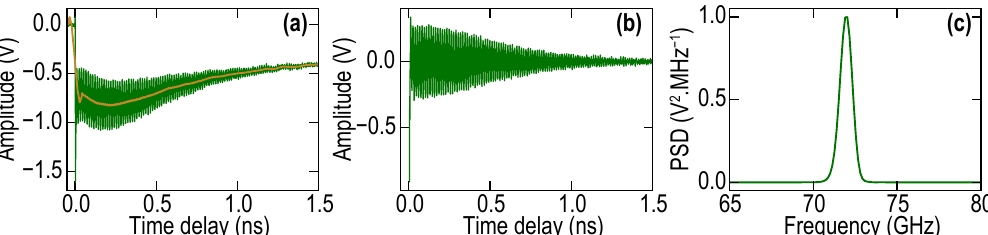
Figure 3. ( a ) Transient reflectivity signal, which follows Ni excitation by the pump pulse in the experiments conducted with pump wavelength of λ = 517 nm (green pump) and probe wavelength of λ = 535 nm (green probe). Number of averages is 10,000. ( b ) Acoustically induced transient optical reflectivity signal and ( c ) its power spectral density (PSD) evaluated in the complete temporal window (0–2 ns) of the